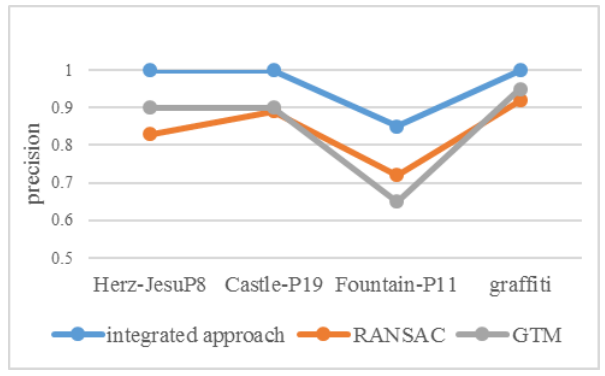
Figure 7. Performance of integrated algorithm on the four